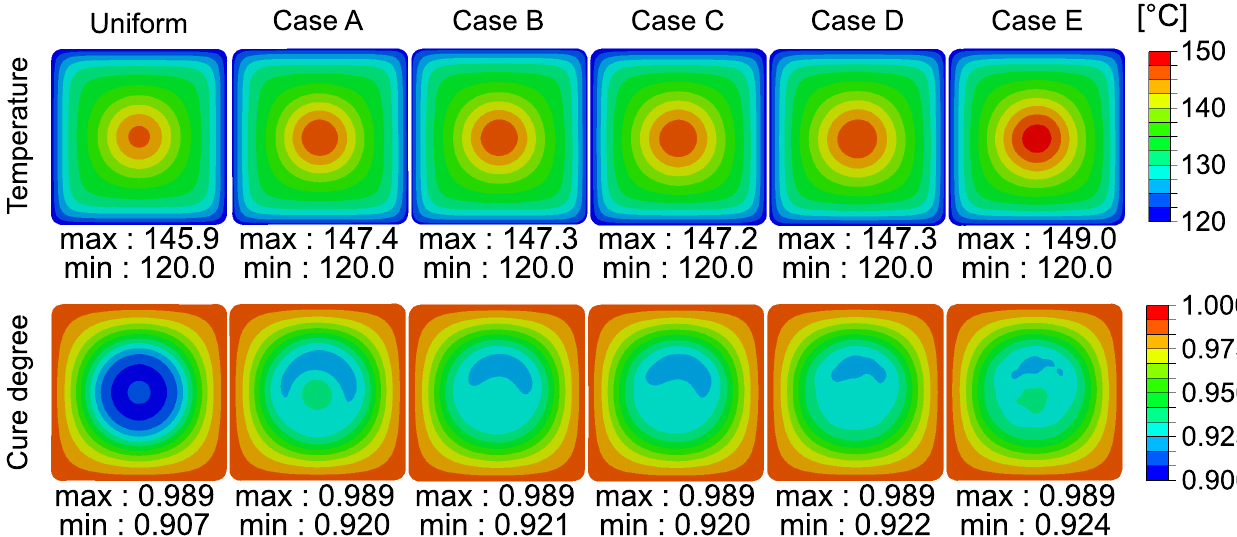
Figure 7. Temperature ( top row ) and cure degree ( bottom row ) distributions throughout the cross-section at the exit of the